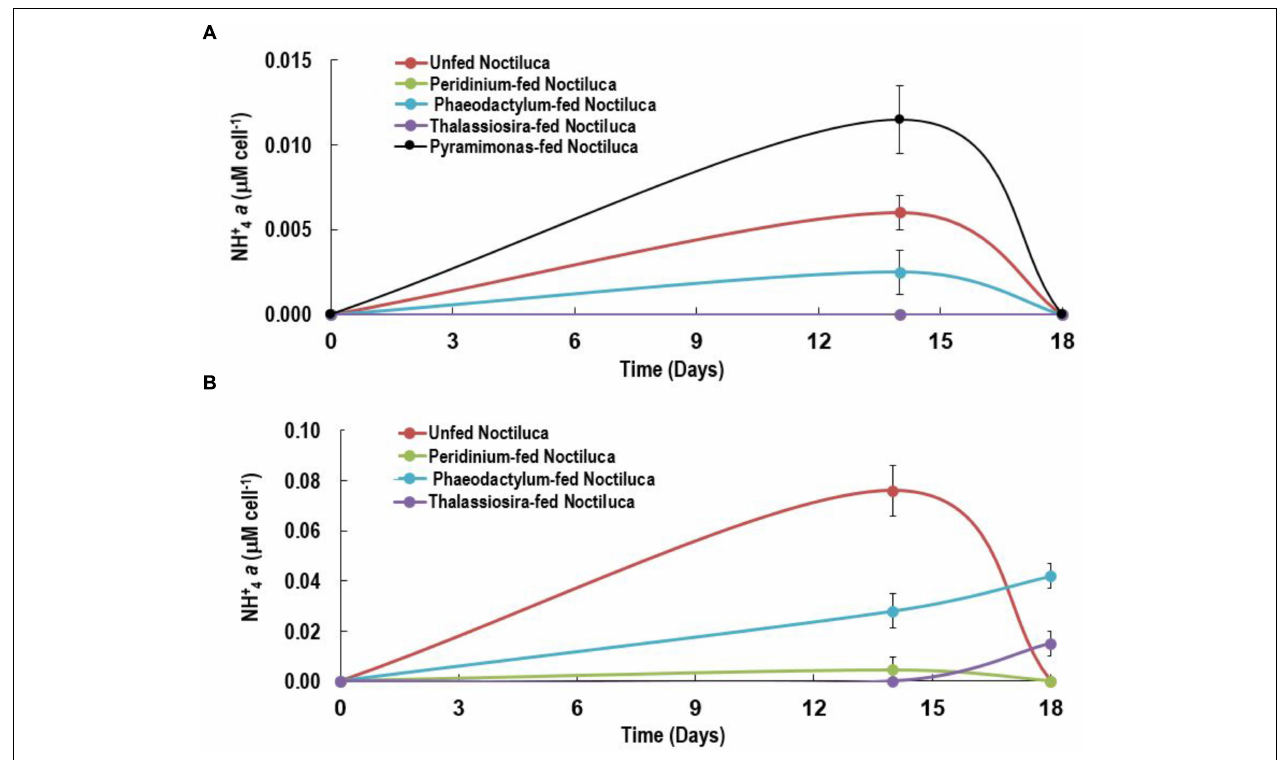
FIGURE 6 | Intracellular NH + 4 concentrations of Noctiluca ( µ g Noctiluca cell - 1 ) for unfed Noctiluca and for Noctiluca fed with P. foliaceum, P. tricornutum , T. weissflogii , and Pyramimonas sp. for (A) optimal (HL) and (B) low light (LL) exposed cultures. Data points represent means ± SE ( n =